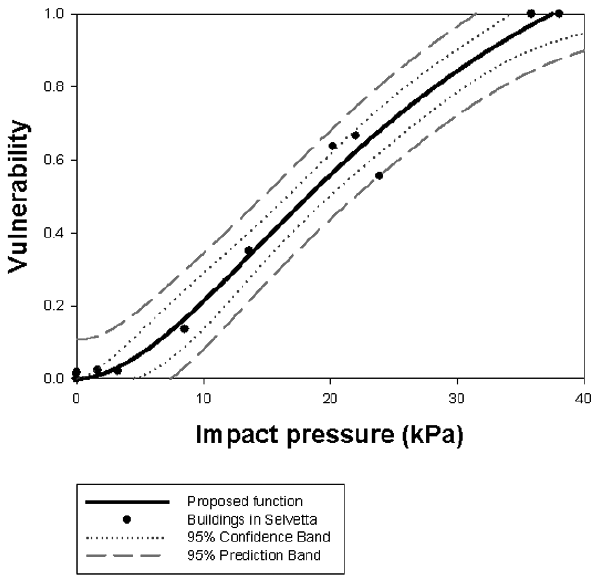
Fig. 10. Proposed vulnerability function for accumulation heights 956 obtained from the modelling. 957